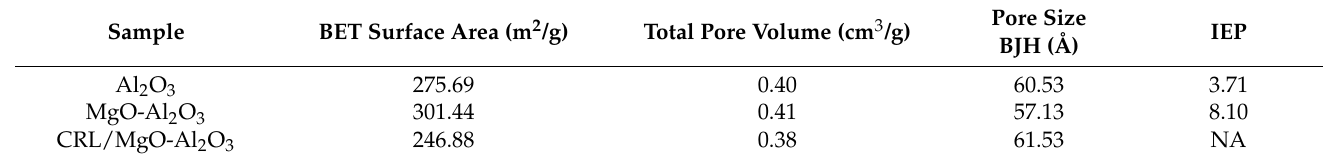
Figure 12. FESEM micrograph of Al 2 O 3 , MgO-Al 2 O 3 , and CRL/MgO-Al 2 O 3 with magnification 5000× Table 6. BET surface area, total pore volume, and pore size evaluated by nitrogen adsorption– desorption and isoelectric point (IEP) of the support and immobilized CRL.